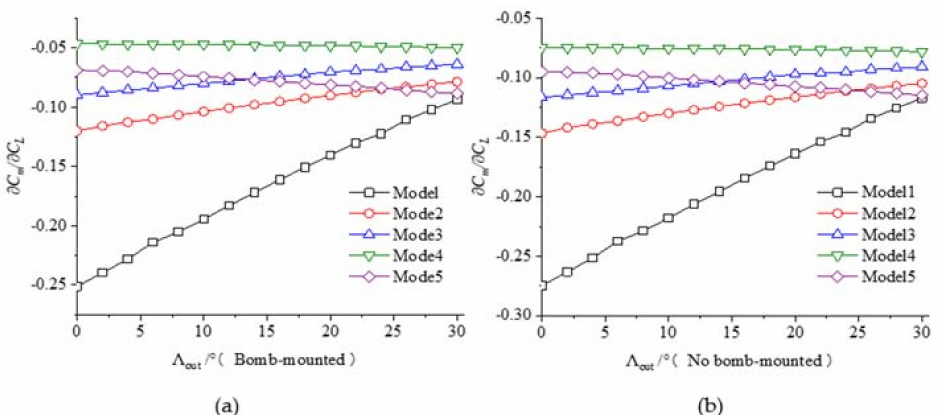
Figure 7. The variation in the longitudinal static stability margin of the multi-section variable- sweep UAV with the sweep angle of the outer section based on the centroid self-trim compensation. ( a ) Releasable payload, ( b ) without releasable